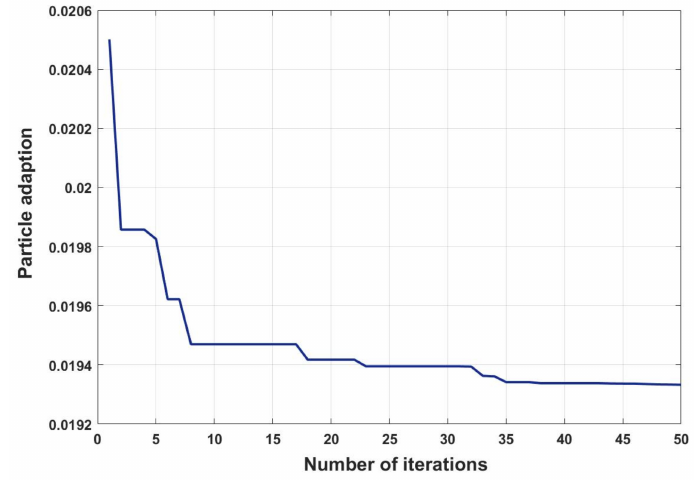
Figure 5. Convergence curve of